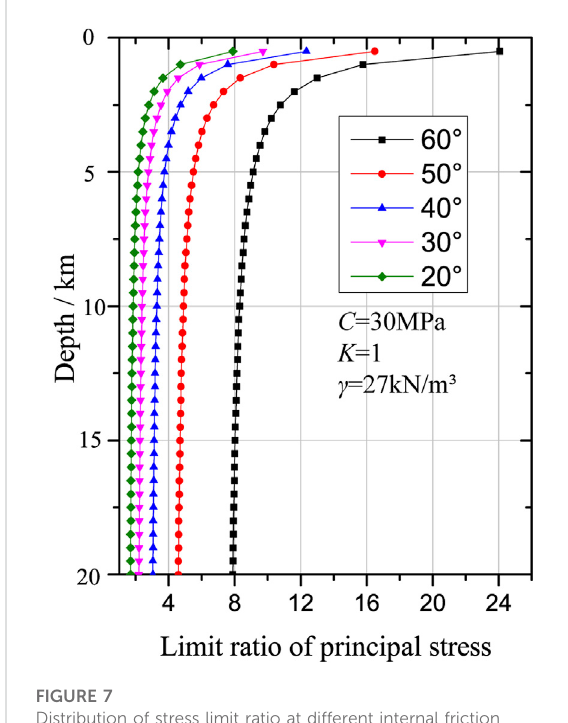
FIGURE 7 Distribution of stress limit ratio at different internal friction angles.